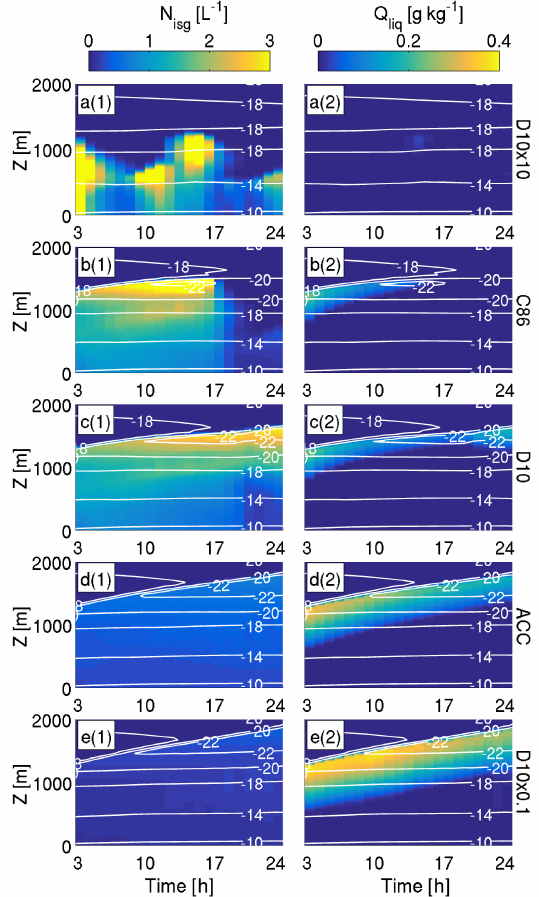
Figure 10. Ocean (case 3) simulations, presented similarly to Figs. 6 and